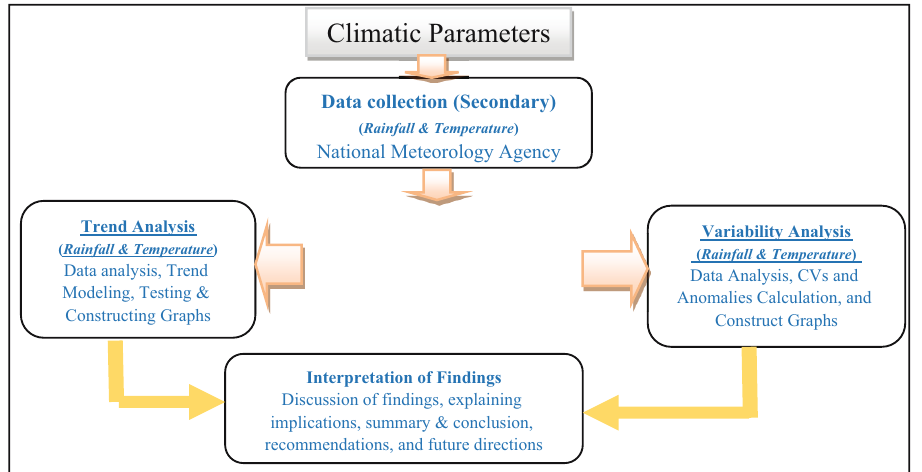
Figure 2: Flowchart of methodological framework used to obtain and analyze climate data, modeling trends, and variability of climatic